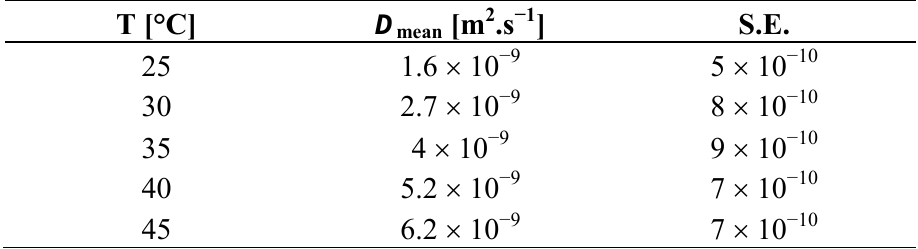
Table 1. The mean mutual diffusion coefficients (D for five different temperatures. (The standard errors estimated for confidence interval at the significant level 95% was computed for 5 measurements of the same sample).